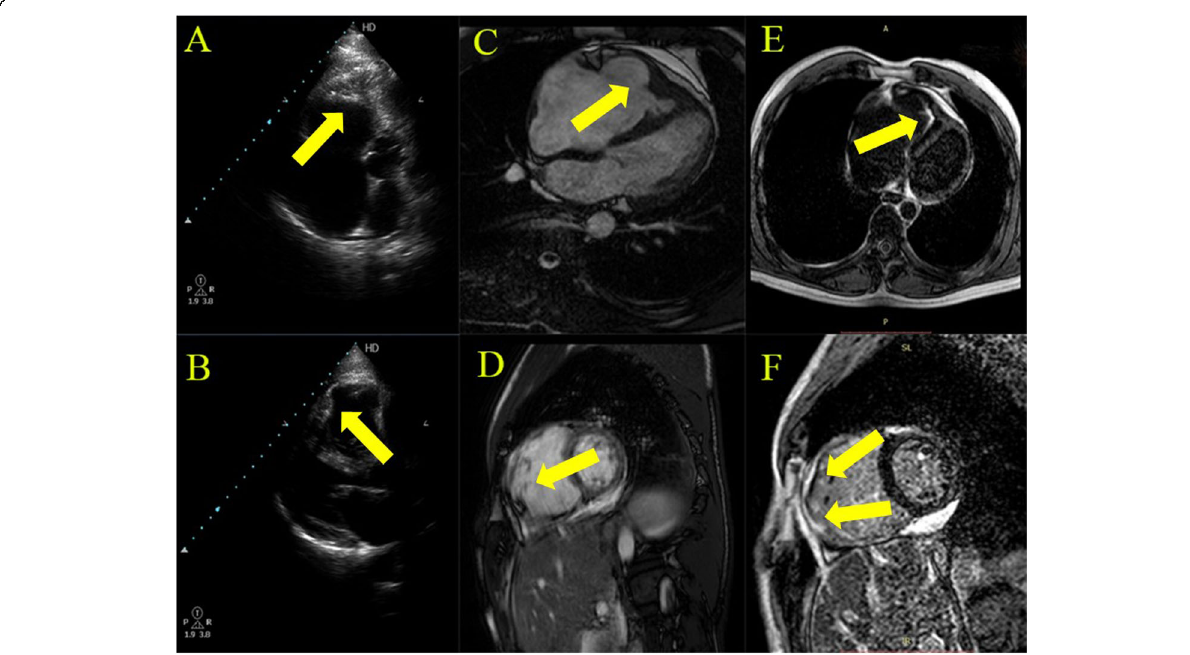
Fig. 1 TTE and CMR of EMF. a 2D TTE, RV apical four-chamber modified view showed obliteration of the RV apex (marked with arrows). b 2D TTE, parasternal long axis view showing dilated RV dimensions (marked with arrows). c , d Cine CMR apical four-chamber and short axis views showing dilated RV dimensions (marked with arrows). e , f LGE CMR imaging showing subendocardial LGE enhancement at the RV apex and RV free wall (marked with